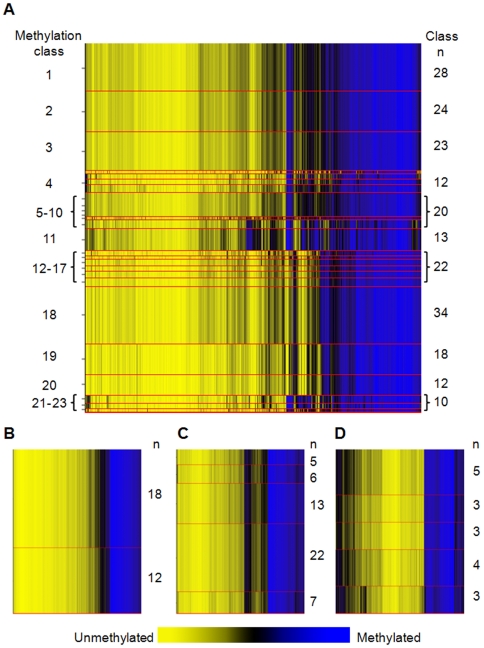
Recursive partitioning mixture models (RPMM) of methylation profiles in normal tissuses.Methylation average β is yellow for unmethylated and blue for methylated. Methylation profile classes are stacked in rows separated by red lines, and class height corresponds to the number of samples in each class. Class methylation at each CpG locus is a mean of methylation for all samples within a class. (A) Methylation profile classes significantly differentiate all normal tissue types (n = 217, P<0.0001). (B) Methylation profile classes from RPMM of adult bloods, class membership is significantly associated with age (P<0.005, n = 30). (C) Methylation profile classes from RPMM of lung tissue samples (n = 53). (D) Methylation profile classes from RPMM of pleural samples (n = 18).